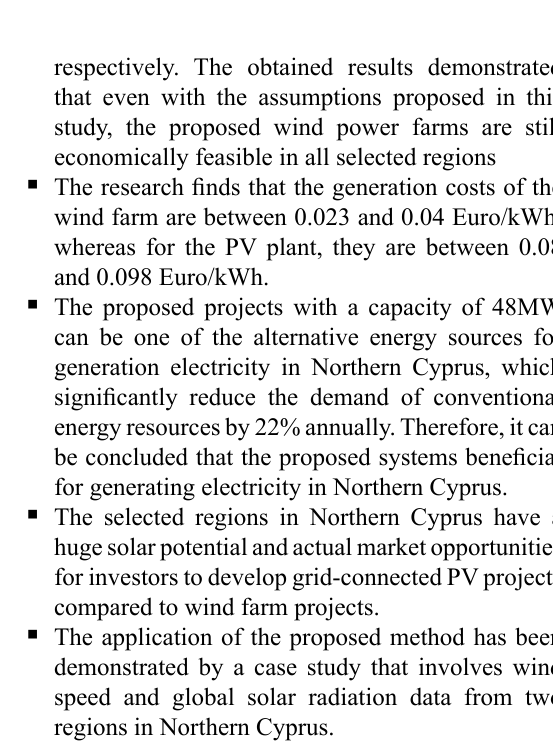
Fig. 10: Power output vs. global solar radiation for Girne